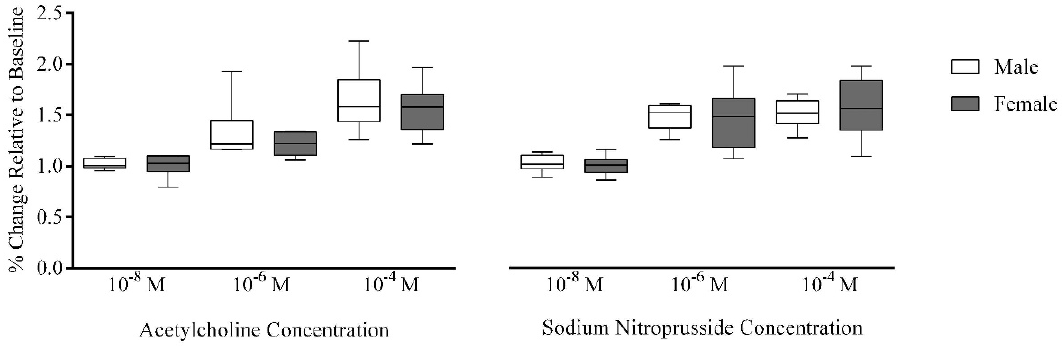
Figure 4 - Arteriolar vasodilation induced by acetylcholine and sodium nitroprusside according